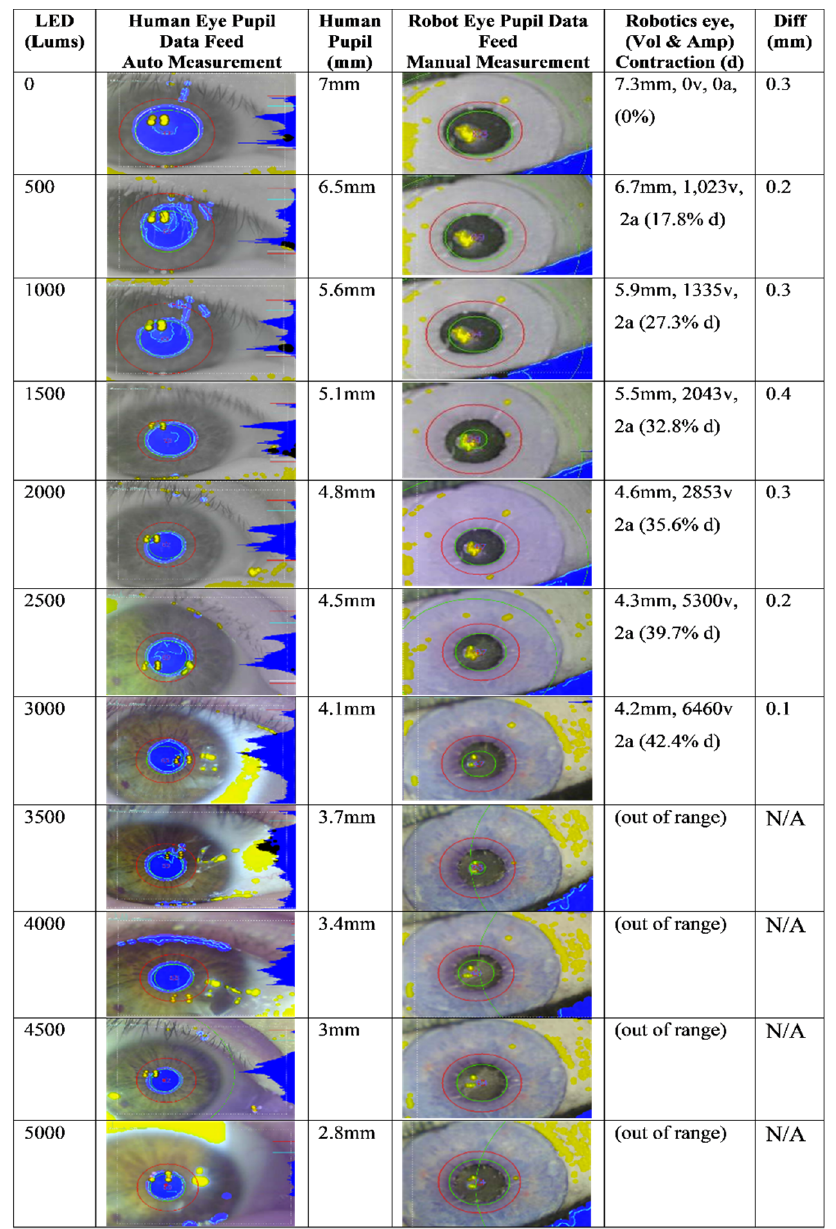
Figure 10. Comparative light test of the human and robotic eyes to alternating light.